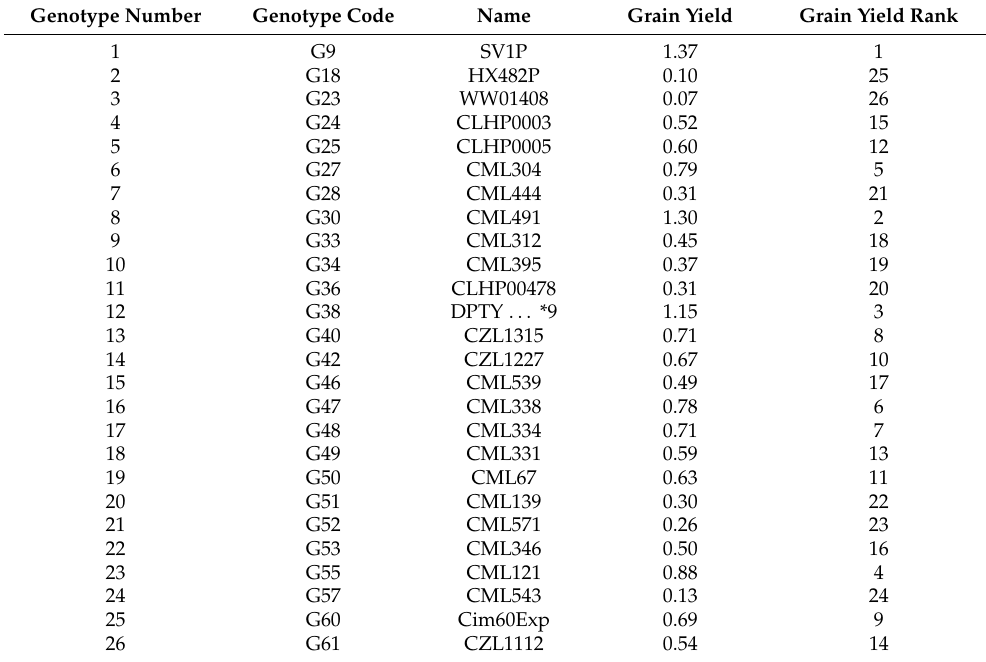
Table 5. Assessment of grain yield potential of inbred lines evaluated across six environments with natural fall armyworm infestation and one managed fall armyworm environment in Zimbabwe during the 2019–2020